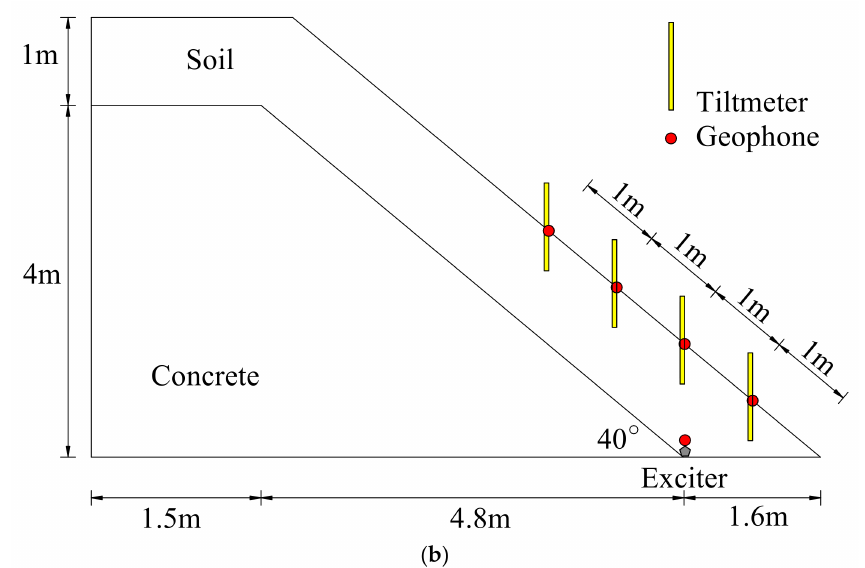
Figure 6. Schematic illustration of the large-scale slope model. ( a ) 3-D illustration; ( b ) Scaled 2-D model.